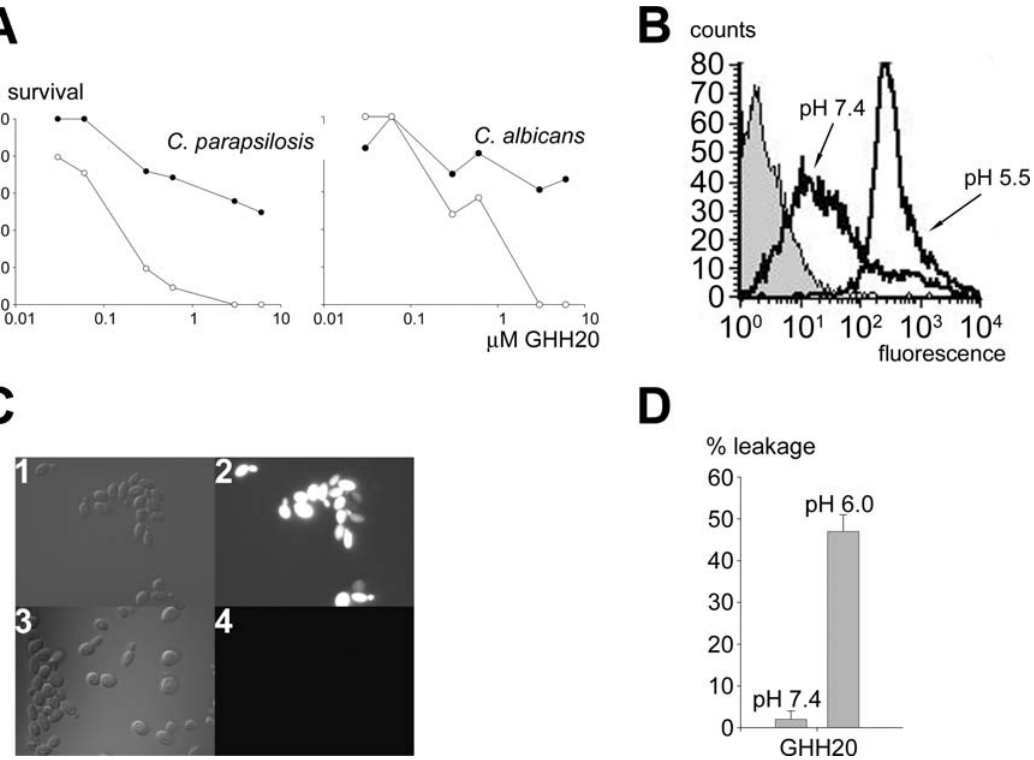
Figure 4. Antifungal activity and fungal binding of GHH20 peptide. ( A ) Antifungal activity of GHH20. C. parapsilosis ATCC 90018 or C. albicans ATCC 90028 (1 6 10 5 cfu) were incubated with GHH20 peptide (0.03 to 6 m M) for 2 hours in 10 mM Tris, pH 7.4 ( N ) or 10 mM MES, pH 5.5 ( # ), plated and the number of cfu determined. A representative experiment (of three) is shown. ( B ) Flow cytometry analysis of binding of GHH20 to fungal membranes. C. parapsilosis (5 6 10 7 cfu) were incubated with 20 m g TAMRA-labeled GHH20 in 10 mM Tris pH 7.4 or 10 mM MES pH 5.5. ( C ) Binding of 2 m g TAMRA-labeled GHH20 peptide to C. parapsilosis ATCC 90018 and inhibition by an excess of heparin. C. parapsilosis were incubated with TAMRA-labeled GHH20 in 10 mM MES (panel 3), pH 5.5 or the same buffer supplemented with heparin (50 m g/ml) (panel 4). The left panel shows Nomarski images (1 and 3), whereas the right panel shows red fluorescence of peptide bound to fungi. ( D ) The GHH20 peptide permeabilizes ergosterol-containing liposomes preferably at pH 6.0. 1 m M GHH20 was used (n=6).